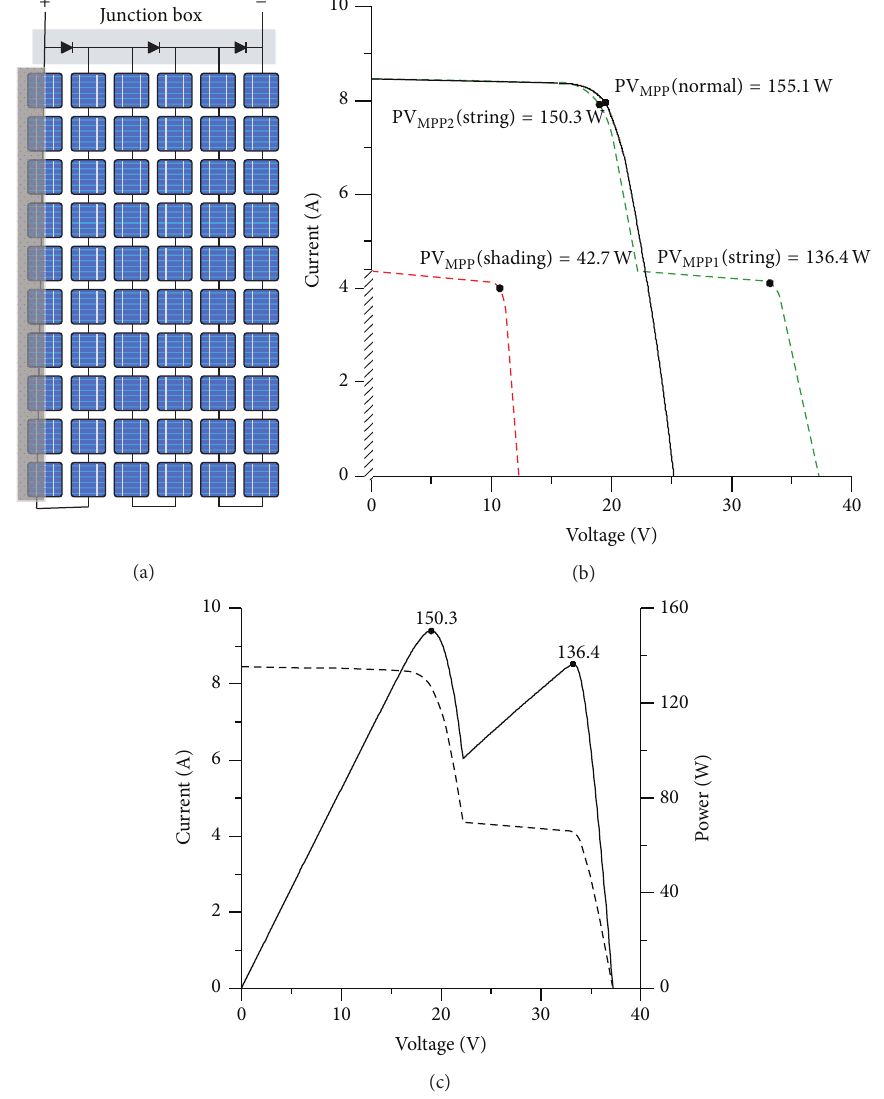
Figure4:(a)SG-2300PVpanelunderpartialshadingcondition:twozonesat1000 W/m 2 irradiationandonezoneat500 W/m 2 , 𝑇 =25 ∘ C;(b) I-V curves for each of the regions under different insolation (solid and dashed lines); (c) I-V and P-V curves for the panel under